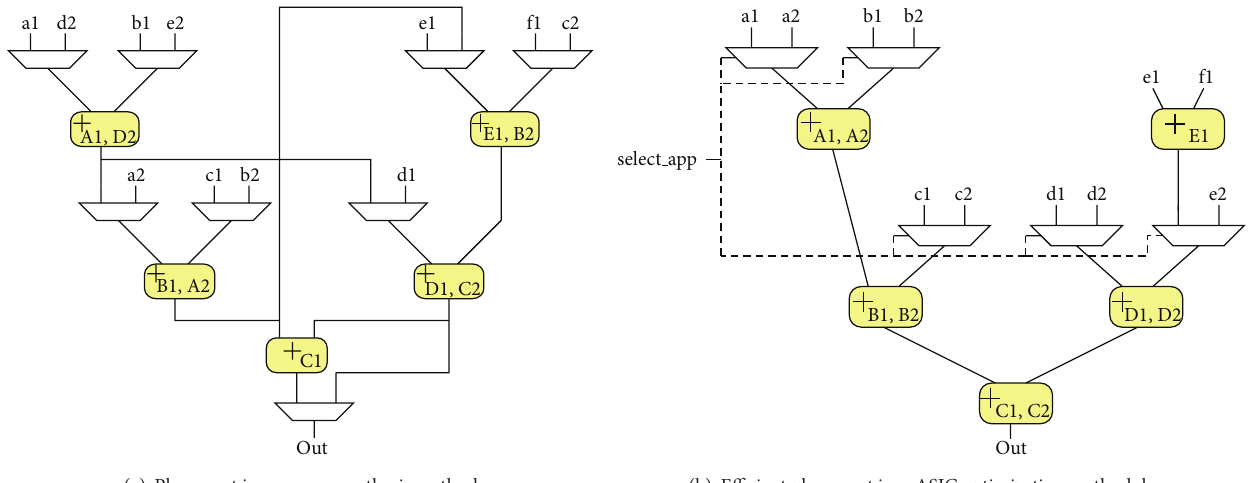
Figure 7: Normal placement versus efficient